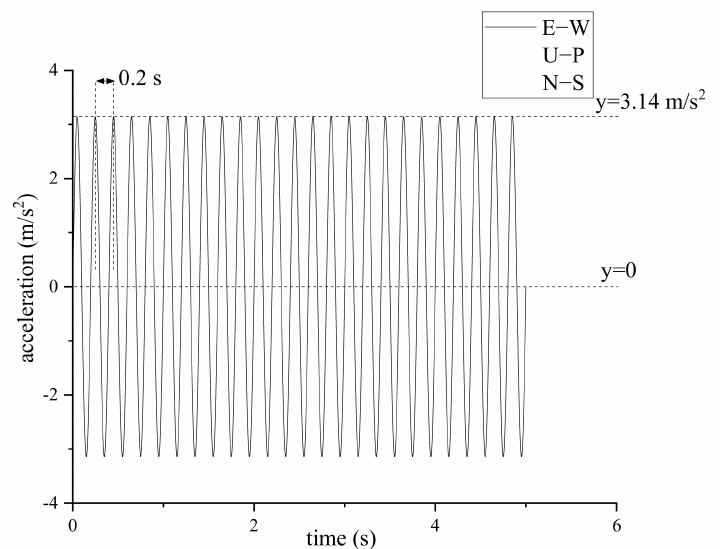
Figure 4. The input acceleration history of the sinusoidal wave used. The holding time is assumed to be 5 s, the amplitude 3.14 m/s 2 , and the period ( T ) 0.2